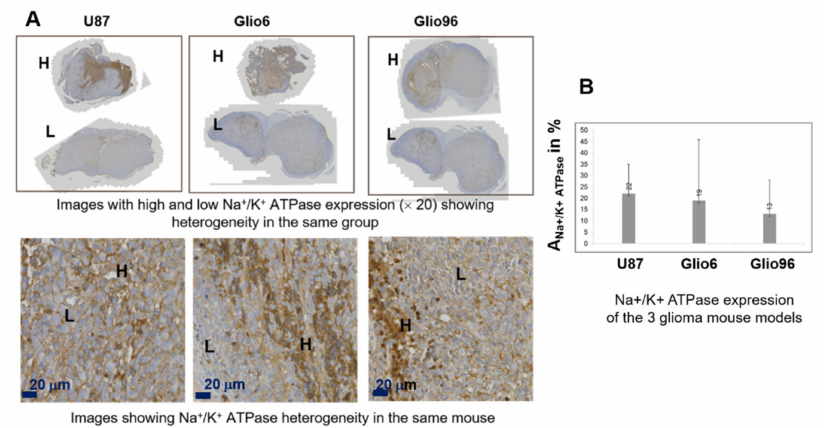
Figure 4. ( A ): IHC of Na + /K + ATPase, stained in brown. All images were obtained from different mice in order to show the high heterogeneity of Na + /K + ATPase expression within glioma groups and within each mouse. Top: For each glioma mouse model, typical images ( × 20) of two mice are presented: with high (H) and low (L) Na + /K + ATPase expression. Bottom: images ( × 200) of the Na + /K + ATPase, in which expressions appear heterogeneous within each image and for all the three glioma models. ( B ): IHC expression of Na + /K + ATPase quantified by A IHC+ % parameter. Standard deviation in the three models was found to be large, demonstrating a high Na + /K + ATPase expression heterogeneity. No statistical differences were found when comparing Glio models to